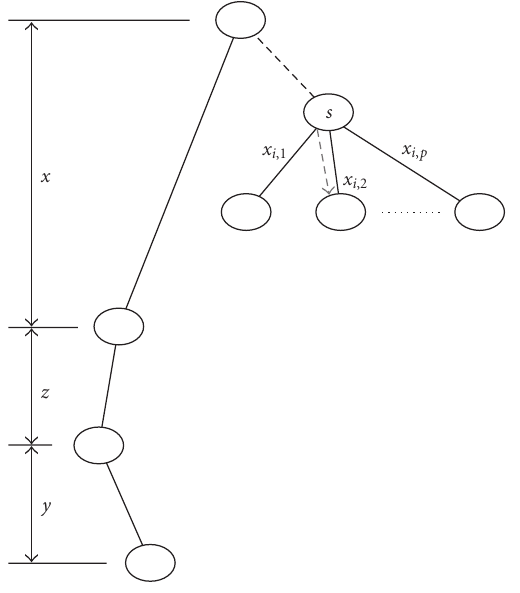
Figure 2: A best-first search